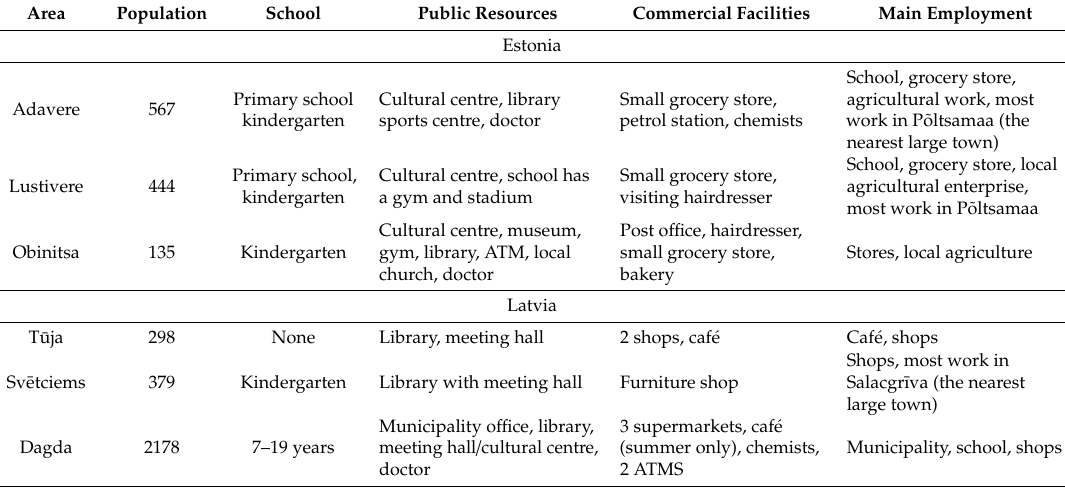
Table 1. An outline of resources in each parish.